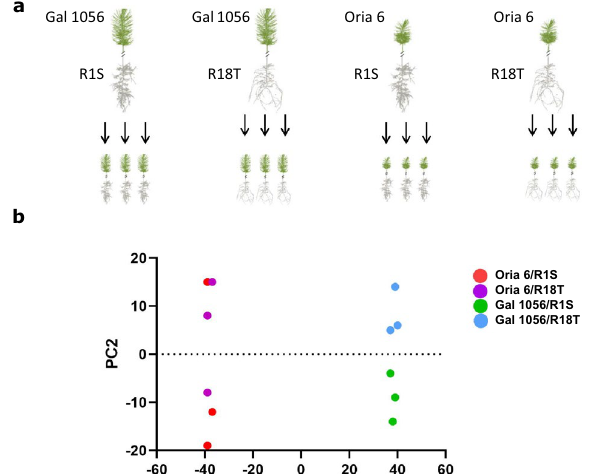
Figure 1. Grafts analyzed combining drought-tolerant (T: R18T) and drought-sensitive (S: R1S) rootstocks with drought-tolerant (O: Oria 6) and drought-sensitive (G: Gal 1056) scions. ( a ) Experimental design, ( b ) PCA plot of Log2-normalized FPKM of the 12 analyzed RNASeq